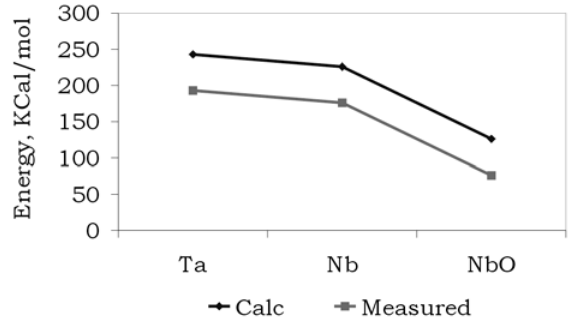
FIGURE 9 Oxidation energy of materials.